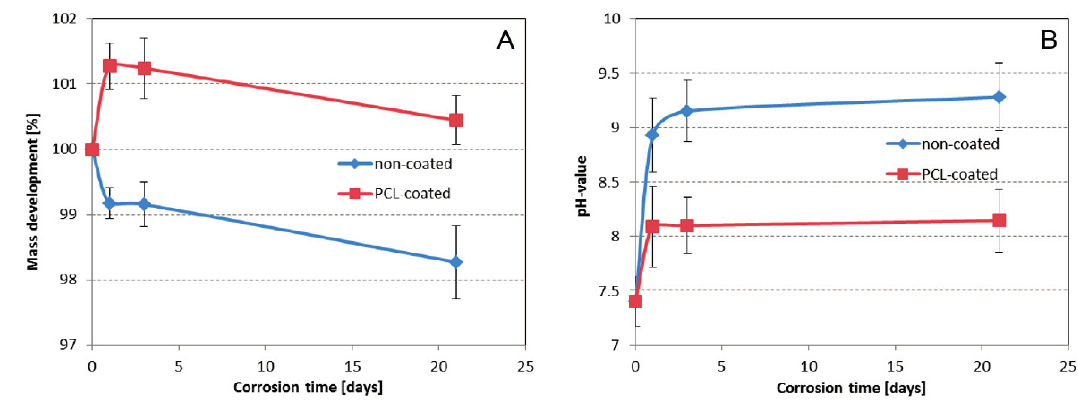
Figure 3. Corrosion-induced mass loss of non-coated and PCL-coated magnesium structures ( A ) and pH-value of surrounding medium ( B ) in Sørensen buffer (0.1 M, pH 7.4) at 37 °C. Data shown as means ±